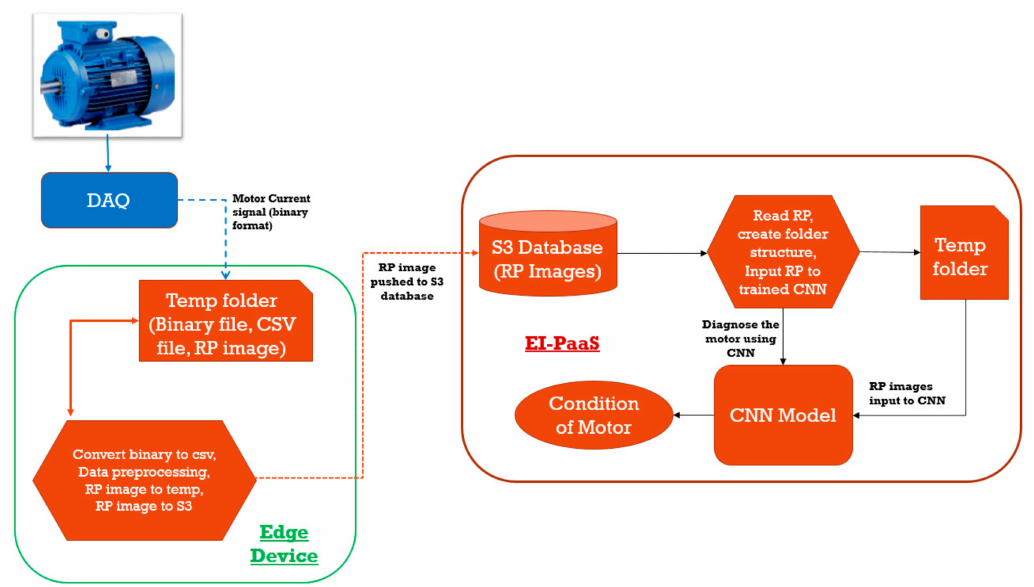
Figure 5. The architecture of the framework setup used in testing / deployment of the CNN model application for motor fault diagnosis. Left: this setup has an induction motor connected to a data acquisition system and Edge device for data preprocessing. Right: this setup has S3 database to store RP, the trained CNN model for motor fault diagnosis in the cloud platform